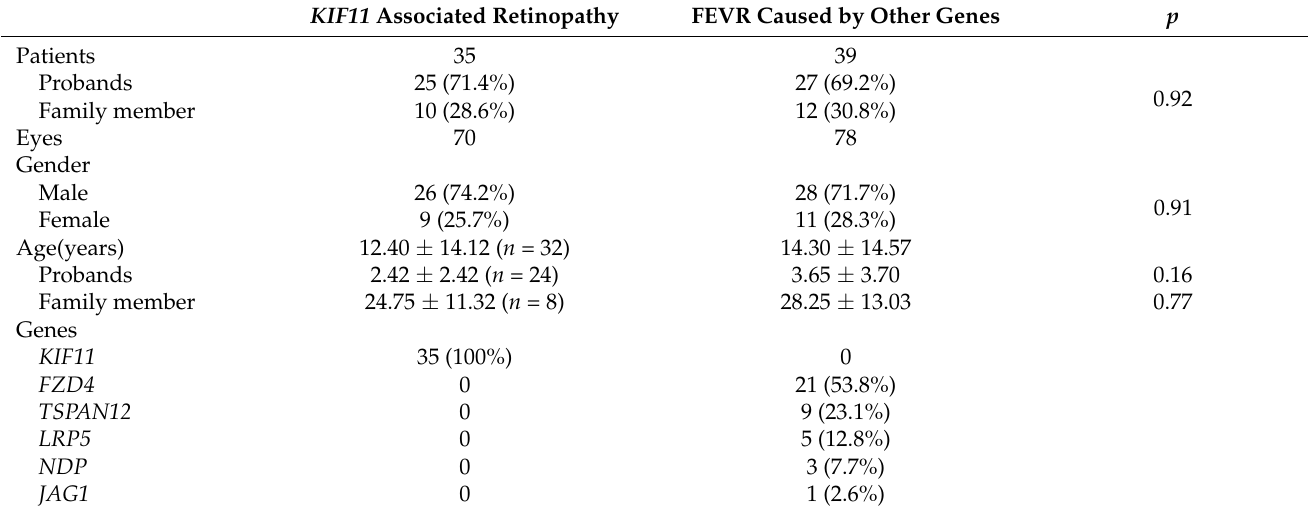
Table 2. Demographic information of the two groups.